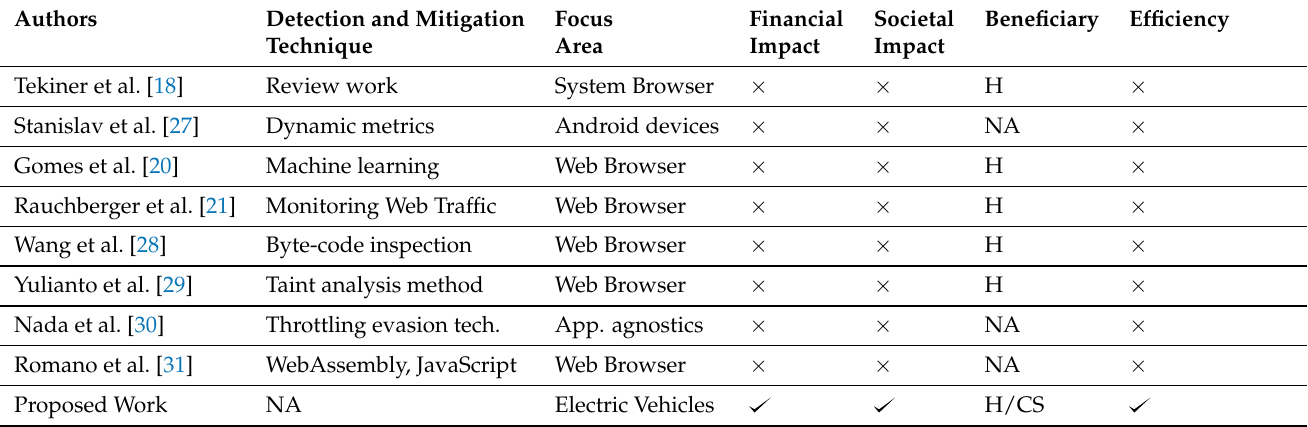
Table 1. Comparison showing recent advancement in cryptojacking. H: hackers, CS: charging